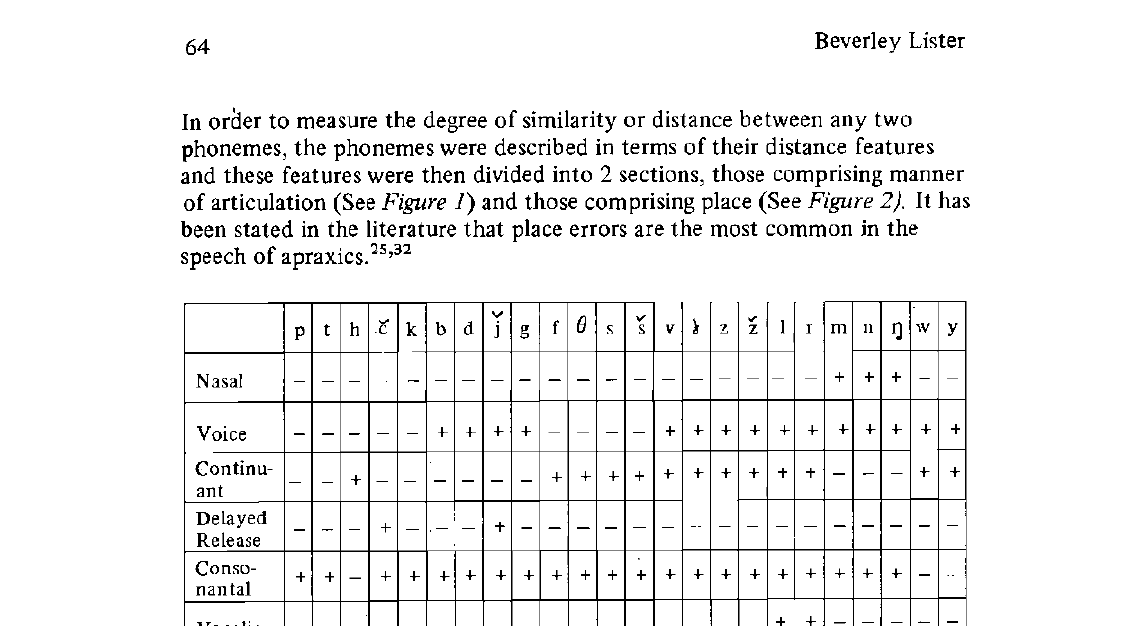
Figure 1: Distinctive features of manner of articulation of the Consonant phonemes of English